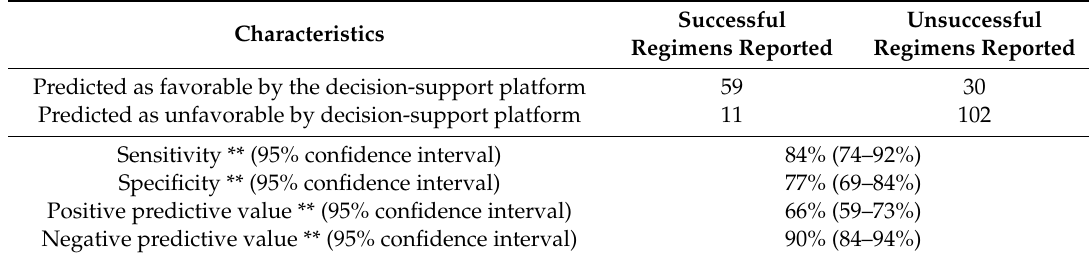
Table 2. Evaluation of the decision-support platform algorithm performance